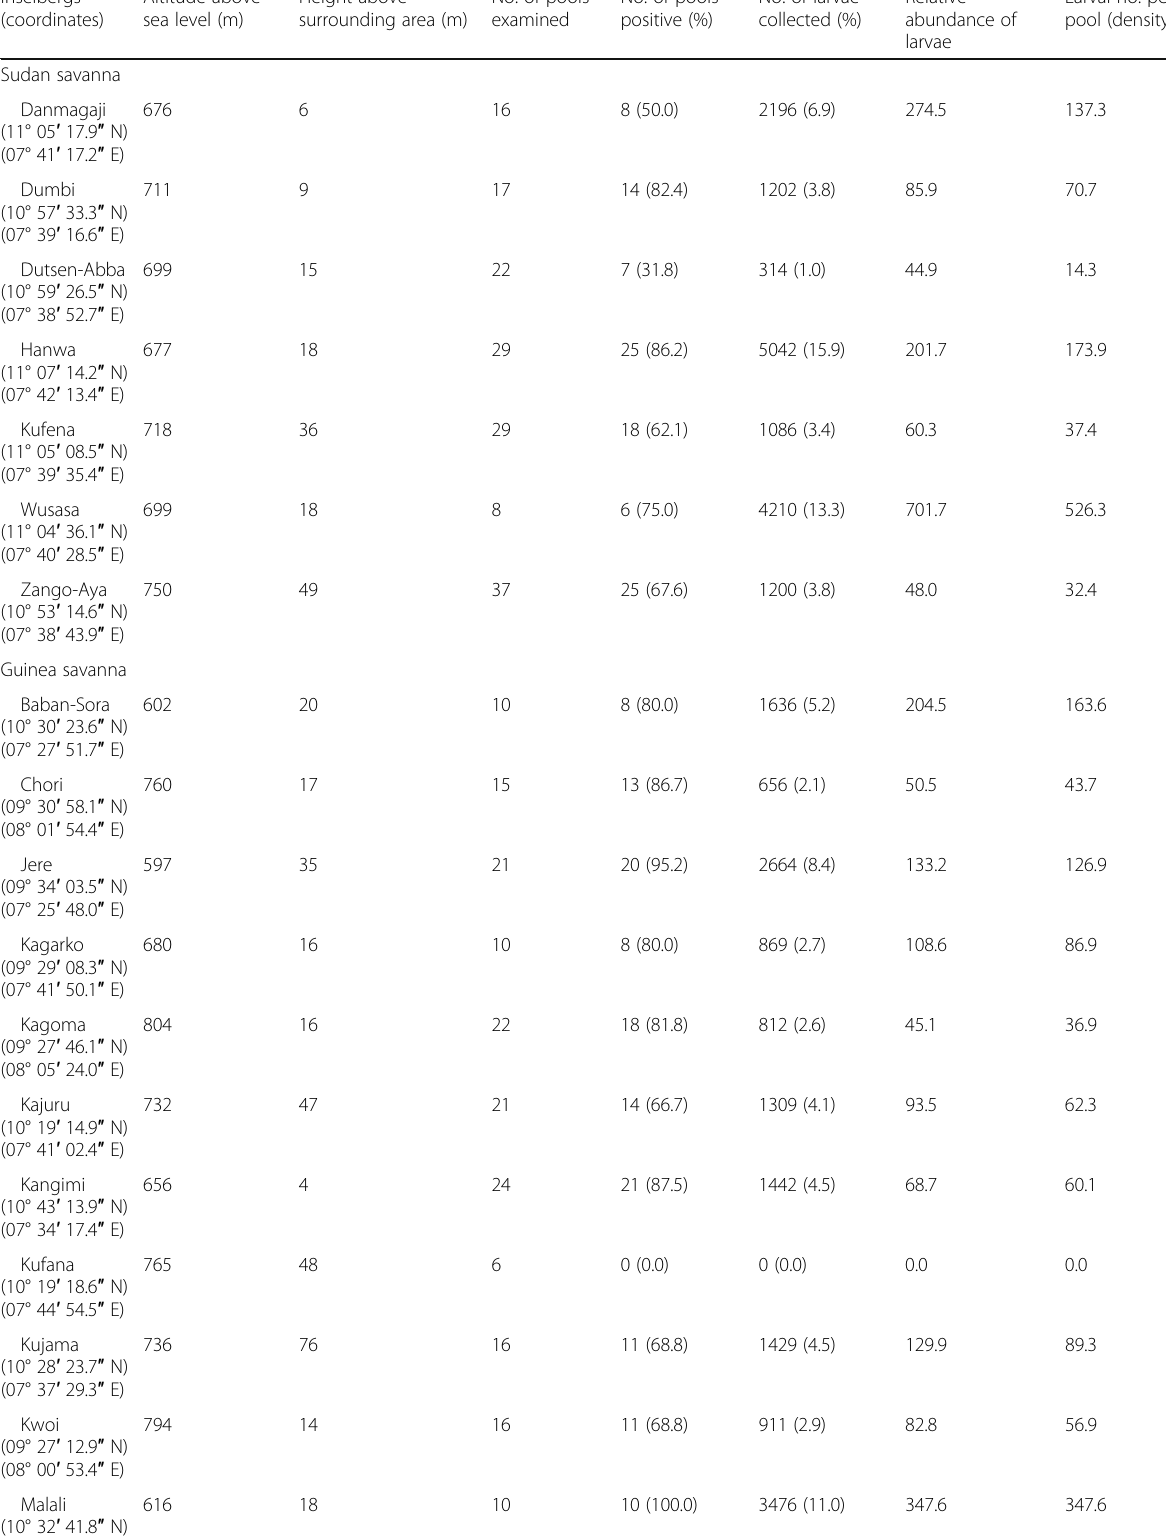
Table 1 Occurrence and abundance of mosquito larvae in rock pools on inselbergs in Kaduna State, Nigeria Inselbergs Altitude above Height above (coordinates) sea level (m) surrounding area (m)